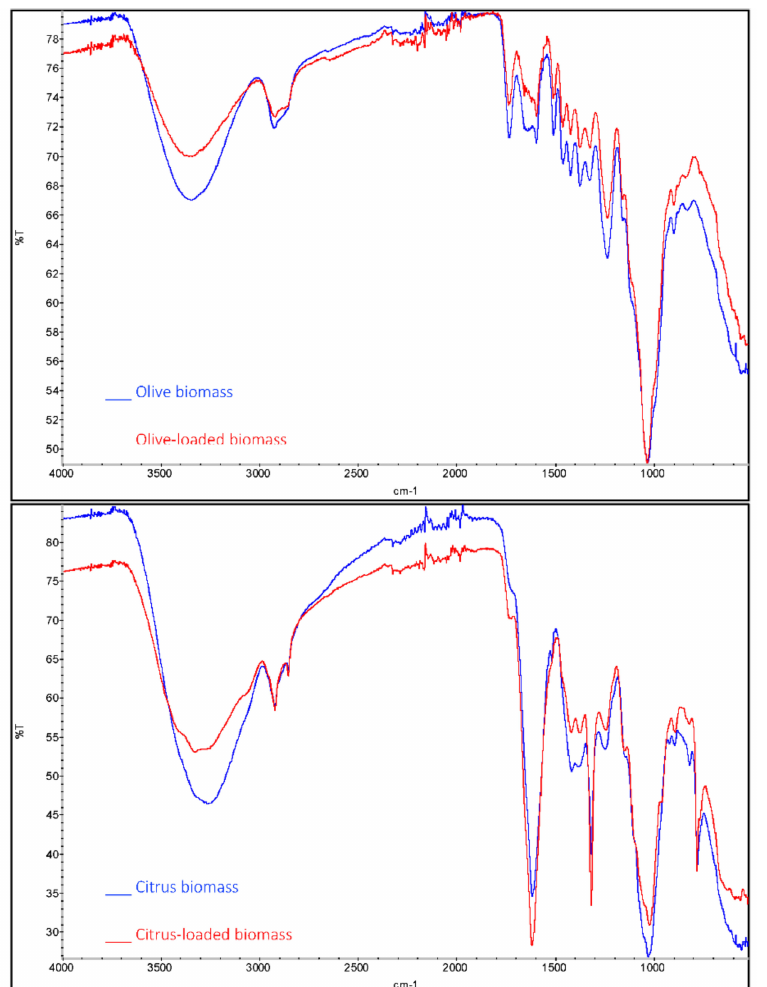
Figure 3. Fourier-transform infrared spectra of the selected agrifood wastes before and after the sorption